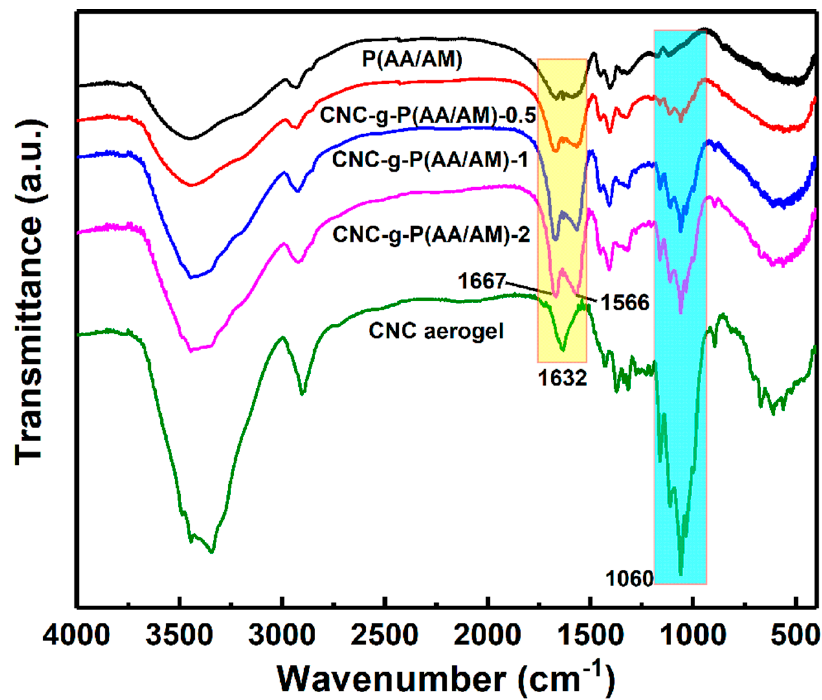
Figure 2. Fourier transform infrared spectroscopy (FTIR) spectra of the poly(acrylic acid-co-acrylamide) (P(AA/AM)), CNC-g-P(AA/AM)-0.5, CNC-g-P(AA/AM)-1, CNC-g-P(AA/AM)-2, and CNC aerogel.